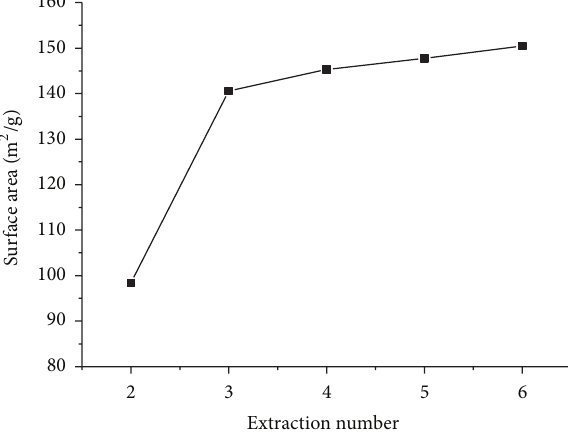
Table 8: Characters and components of nonideal